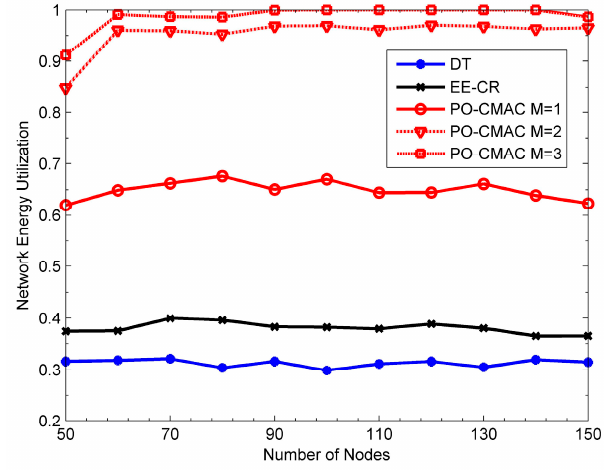
Figure 13. Number of data packets transmitted by each node with varying N at non-uniform traffic load.